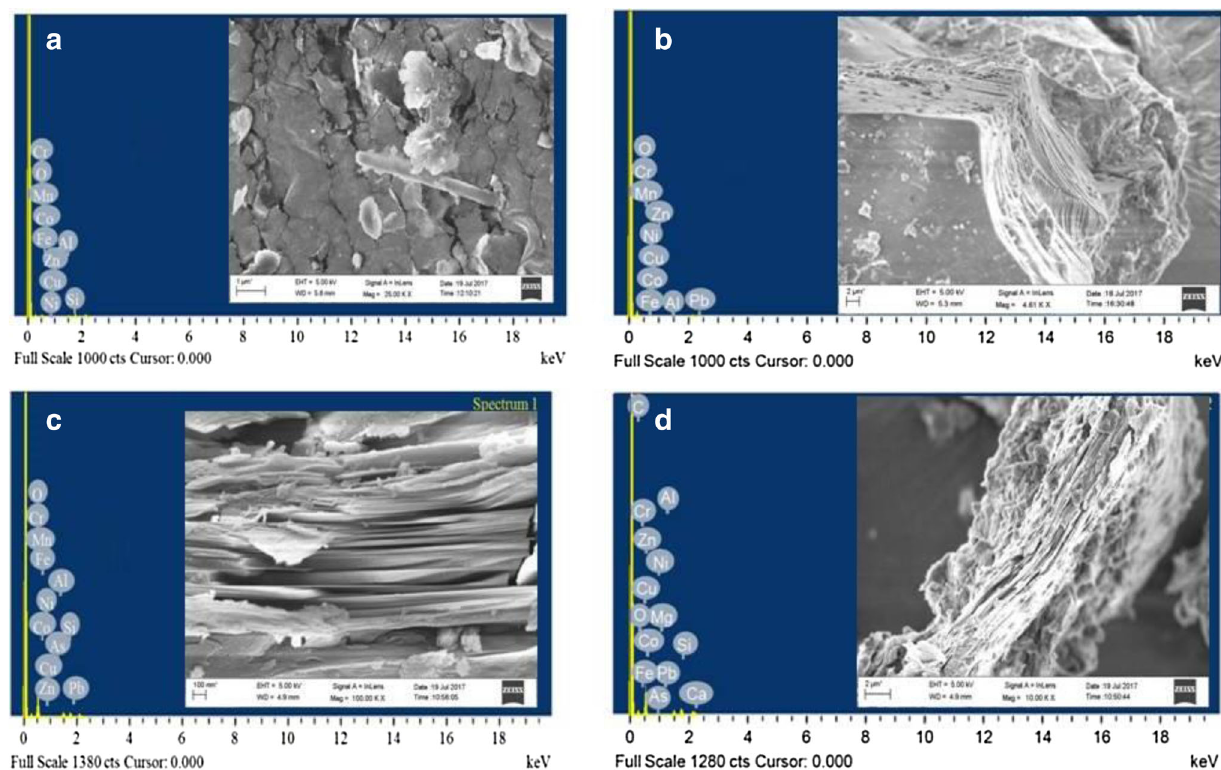
Fig. 36 SEM-EDS of leached coal LC-20A ( e ), LC-60A ( f ) and OB samples LOB-15A ( g ), LOB-15B ( h